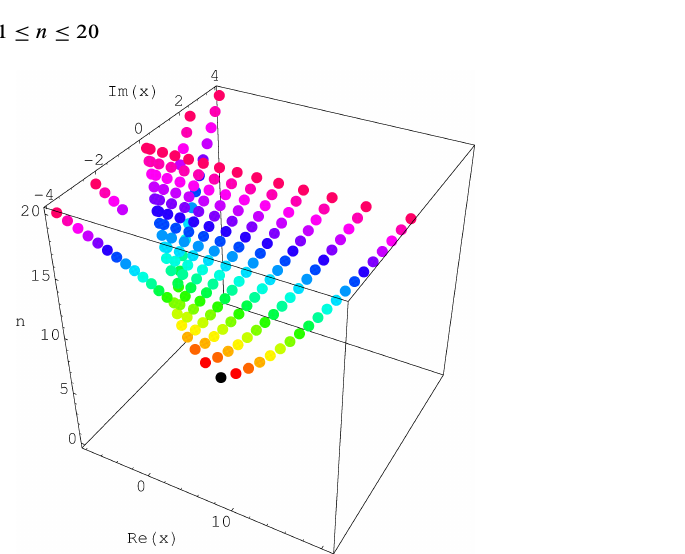
Our numerical results for approximate solutions of real zeros of the generalized Bell polynomials B n .x; (cid:21)/ are displayed (Tables 1, 2). Plot of real zeros of B n .x; (cid:21)/ for 1 (cid:20) n (cid:20) 20 structure are presented (Figure